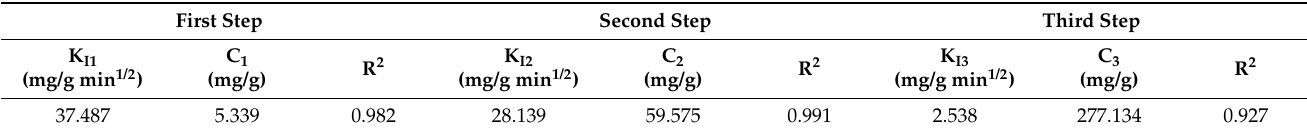
Table 3. Parameters of the intraparticle diffusion model of MeO adsorption on MO C-ZnCl